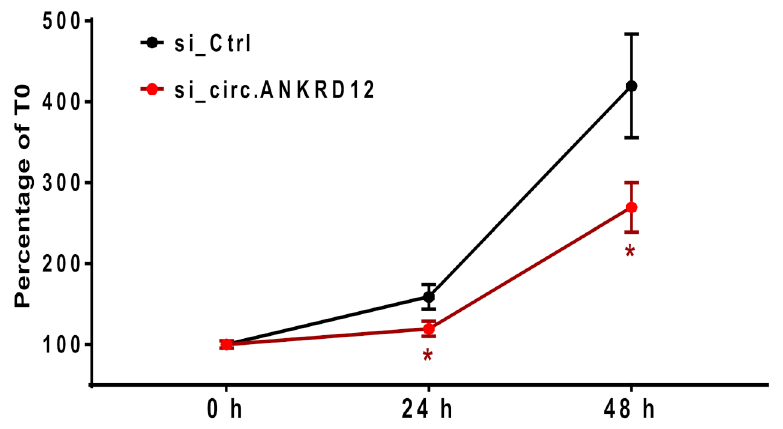
Figure 8. Knockdown of circular ANKRD12 leads to reduced endothelial proliferation. HUVEC were transfected with siRNA specific for the back-splice junction of circANKRD12. As a negative control a non-targeting siRNA (si_Ctrl) was used. Three independent proliferation assays (each n = 4) were aggregated by averaging cell numbers expressed as percentages relative to time point 0 ( n = 12; * p <